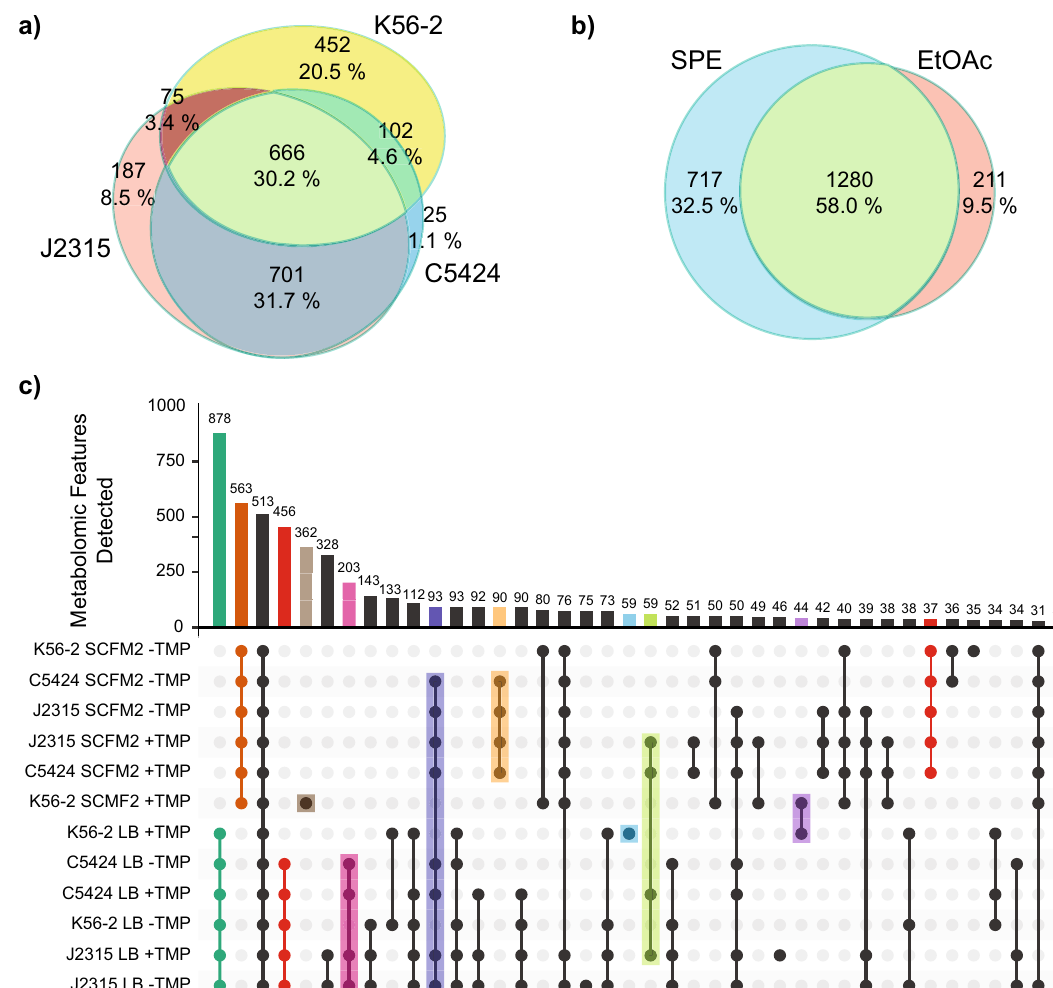
Figure 2. Overview of global metabolomic profiles across experimental conditions. ( a ) Euler Diagram showing distribution of metabolomic features across three B. cenocepacia strains used in this experiment, regardless of culturing conditions, time of harvest, or extraction methods used. ( b ) Euler diagram displaying features detected at 48 h with liquid–liquid extractions using EtOAc or solid-phase extraction methods (SPE), regardless of other experimental conditions. ( c ) UpSet plot displaying number of features detected in each combination of bacterial strain, growth media, and trimethoprim exposure condition. For the sake of clarity, only the top forty combinations of conditions in which the most unique features were detected are